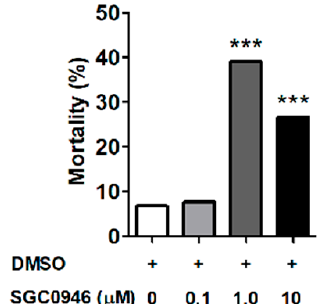
Figure 3. E ff ect of inhibitor SGC0946 on O. moubata larval molting. Larvae were immersed Figure 3. Effect of inhibitor SGC0946 on O. moubata larval molting. Larvae were immersed for 15 minutes either in DMSO (+, control), or the inhibitor SGC0946 (dissolved in DMSO) at three different concentrations, 0.1 μ M, 1 μ M, and 10 μ M. Larvae were then dried on a filter paper, fed on mice and